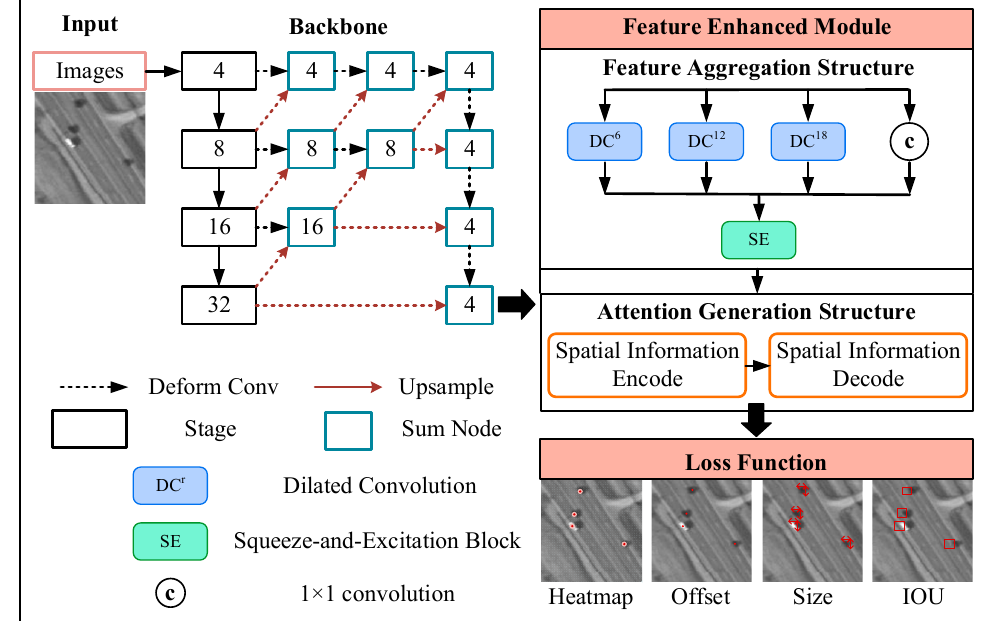
Figure 1. The structure of FE-CenterNet.